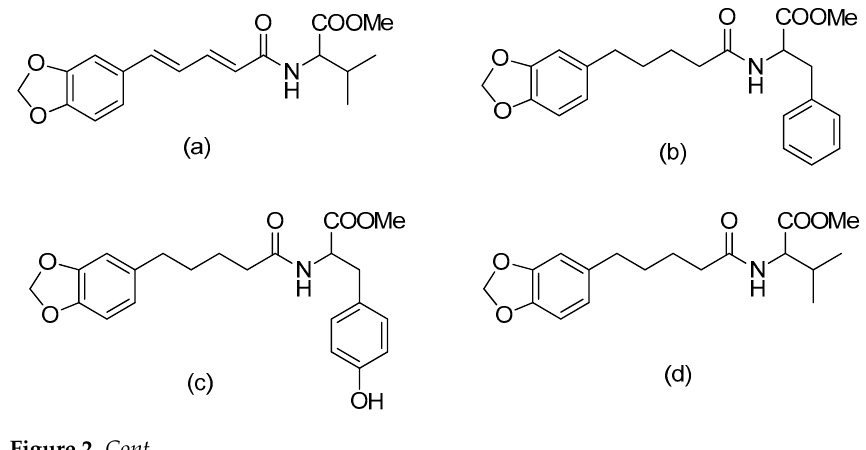
Figure 2. ( a ) Piperoyl-L-valine methyl ester; ( b ) tetrahydropiperoyl-L-phenylalanine methyl ester; ( c ) tetrahydropiperoyl-L-tyrosine methyl ester; ( d ) tetrahydropiperoyl-L-valine methyl ester; ( e ) tet- rahydropiperoyl-L-methionine methyl ester; ( f ) tetrahydropiperoyl-L-tryptophan methyl ester. 2.1.2. Camptothecin Camptothecin (Figure 3), a quinolone type of alkaloid, is a potent antitumor agent isolated from Camptotheca acuminate [41,42]. However, it has a low solubility and some adverse effects [43,44]. One of the strategies used to overcome this problem is the conju- gation of camptothecin with poly- α -L-glutamic acid [45]. Figure 3. Camptothecin. The conjugation of 50 kDa poly-R-(L-glutamic acid) (PG) and L-camptothecin was achieved by means of the esterification of the hydroxyl group at the C-20 position with amino acid as a linker (Scheme 3). Amino acid was added to a solution of camptothecin, DMAP and DIPC in DMF at room temperature to form amino acid–camptothecin. Then, 50% TFA was used to deprotect the amino acid linker. Thereafter, an amino-acid-linked camptothecin solution in anhydrous DMF was added to the poly-R-(L-glutamic acid) so- lution. The DMAP and DIPC in DMF were gradually added to the combination and chilled in an ice bath. The mixture was stirred for two days at room temperature [45].